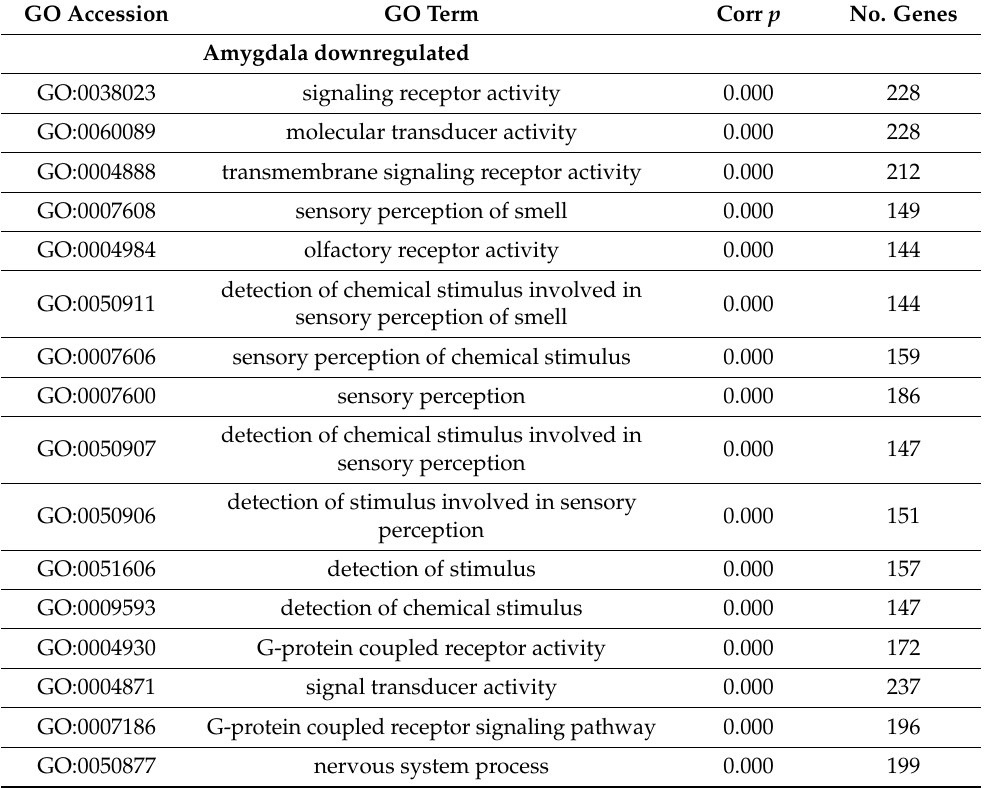
Table 5. Differentially expressed genes enriched in GO terms in amphetamine-exposed rats after four weeks of lithium